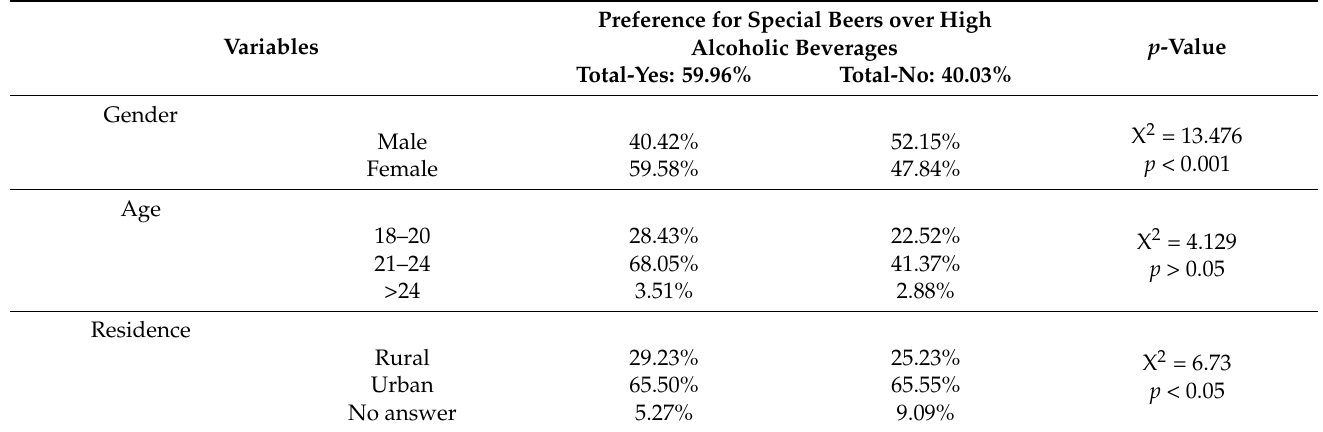
Table 5. The preferences for special beers over high alcoholic beverages, classified based on gender, age, and students’ residence, along with the statistical interpretation. Preference for Special Beers over High Variables Alcoholic Beverages p